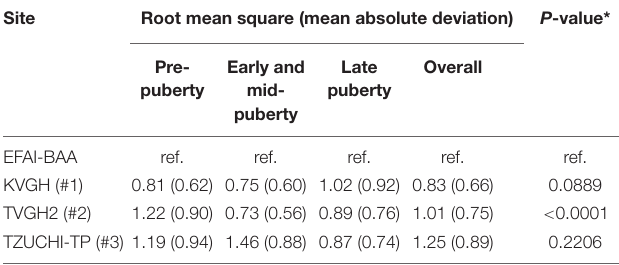
TABLE 5 | Root mean square and mean absolute deviation of bone age assessment in each puberty